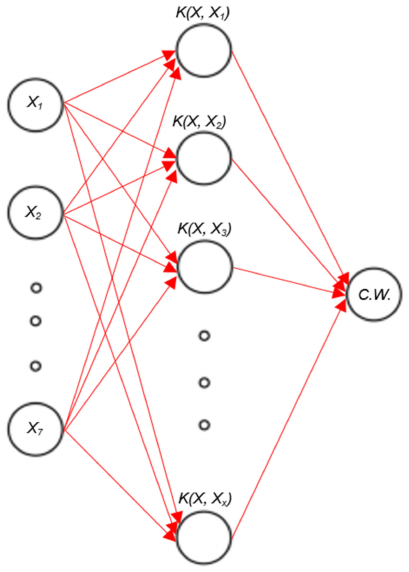
Figure 8. The SVM framework (Dot products in kernel